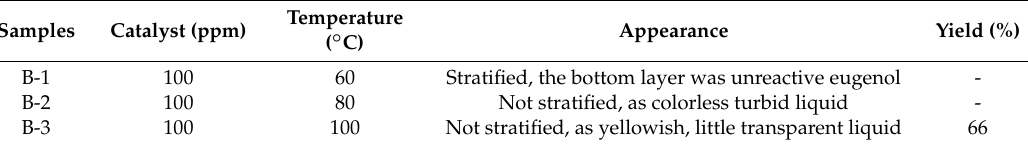
Table 3. Effect of reaction temperature on activity of catalyst.